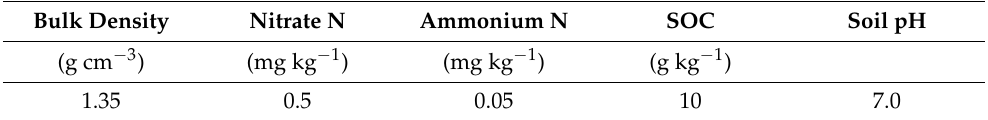
Table 1. Soil properties of the study